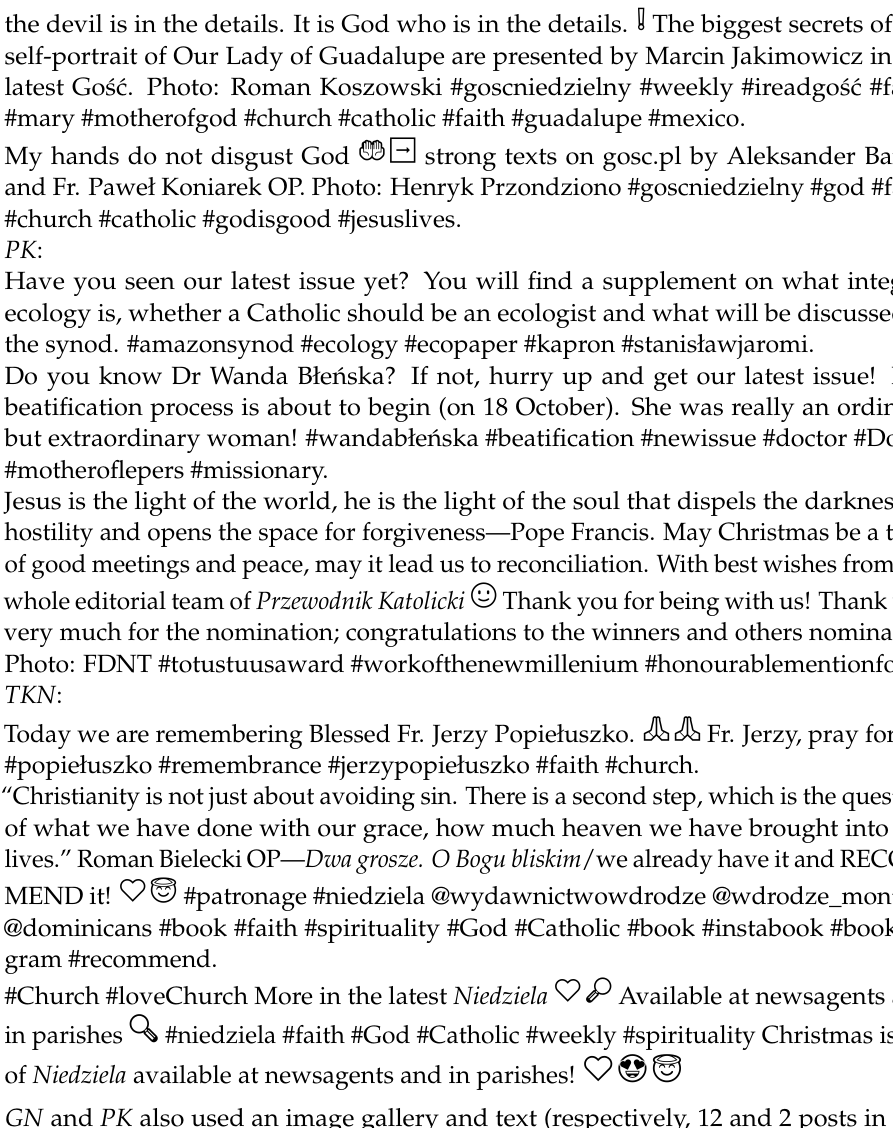
Table 6. Topics of posts on the Instagram profiles of the selected Catholic weeklies (2019– 2020).